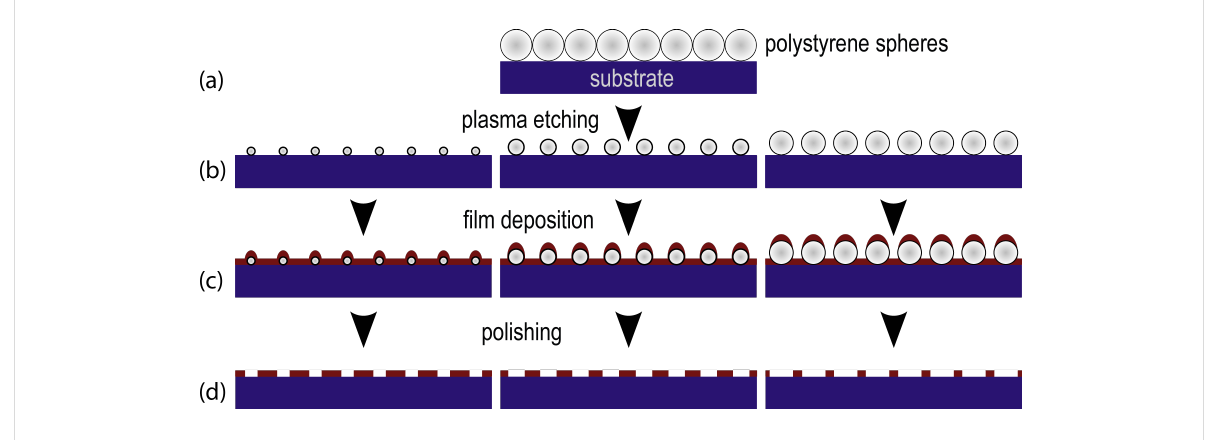
Figure 1: Preparation process of magnetic antidot arrays. After self-assembly of a monolayer monodisperse PS spheres (a), the spheres are homo- geneously etched down to the chosen mask (b) for small, average and large antidot diameters from left to right. In (c) a magnetic film is deposited. Finally, the mask including the magnetic caps is removed by chemo-mechanical polishing (d).